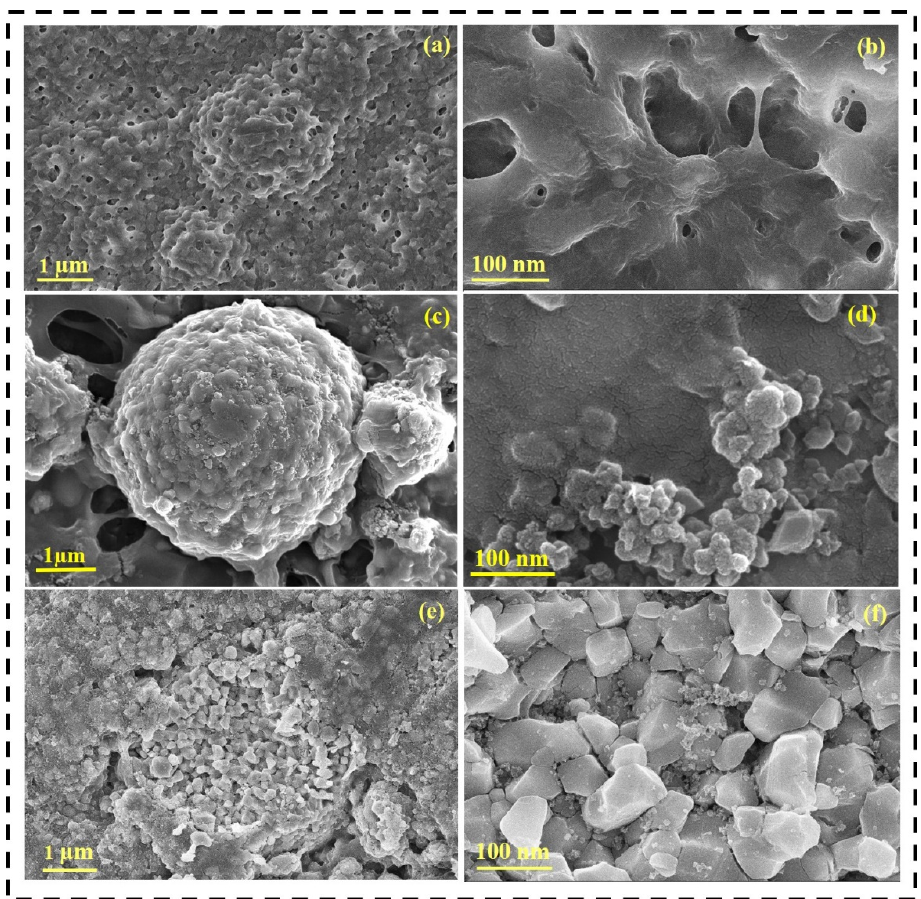
Figure 8. ( a ) Rate capability studies of NCM811/Li half-cell using PM-, PC-, and PMC-based GPEs; ( b ) Comparative rate capability studies for LE and GPE (PMC); ( c ) cyclic stability and capacity re- tention for LE and GPE (PMC).